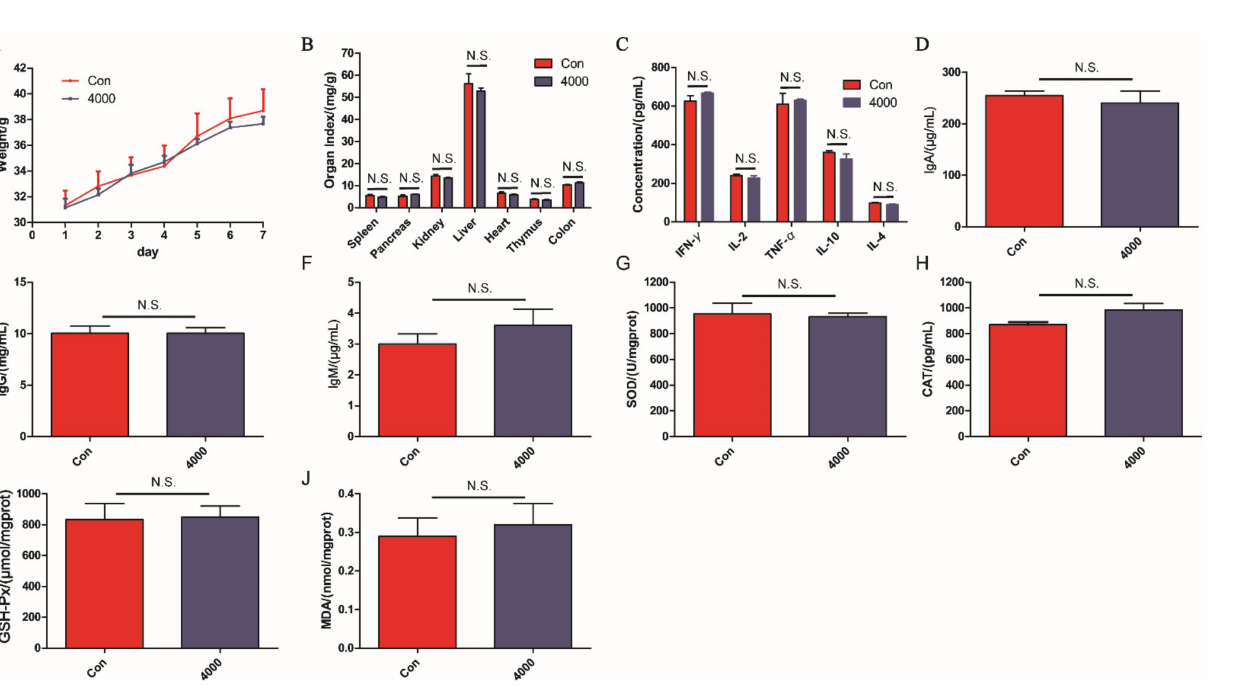
Figure 3. The acute toxicity of OPA in vivo. The large dose OPA affected weight ( A ) and organ index ( B ), cytokines (IFN- γ , IL-2, TNF- α , IL-10, IL-4) ( C ) and immunoglobulins (IgA, IgG, IgM) ( D – F ) in serum, oxidative stress indexes (SOD, CAT, GSH-Px, MDA) in liver ( G – J ). Con was control group, 4000 was 4000 mg/kg OPA group. Data were expressed as the mean ± SD ( n = 6), the statistical analyses were done with t -test. N.S. was no